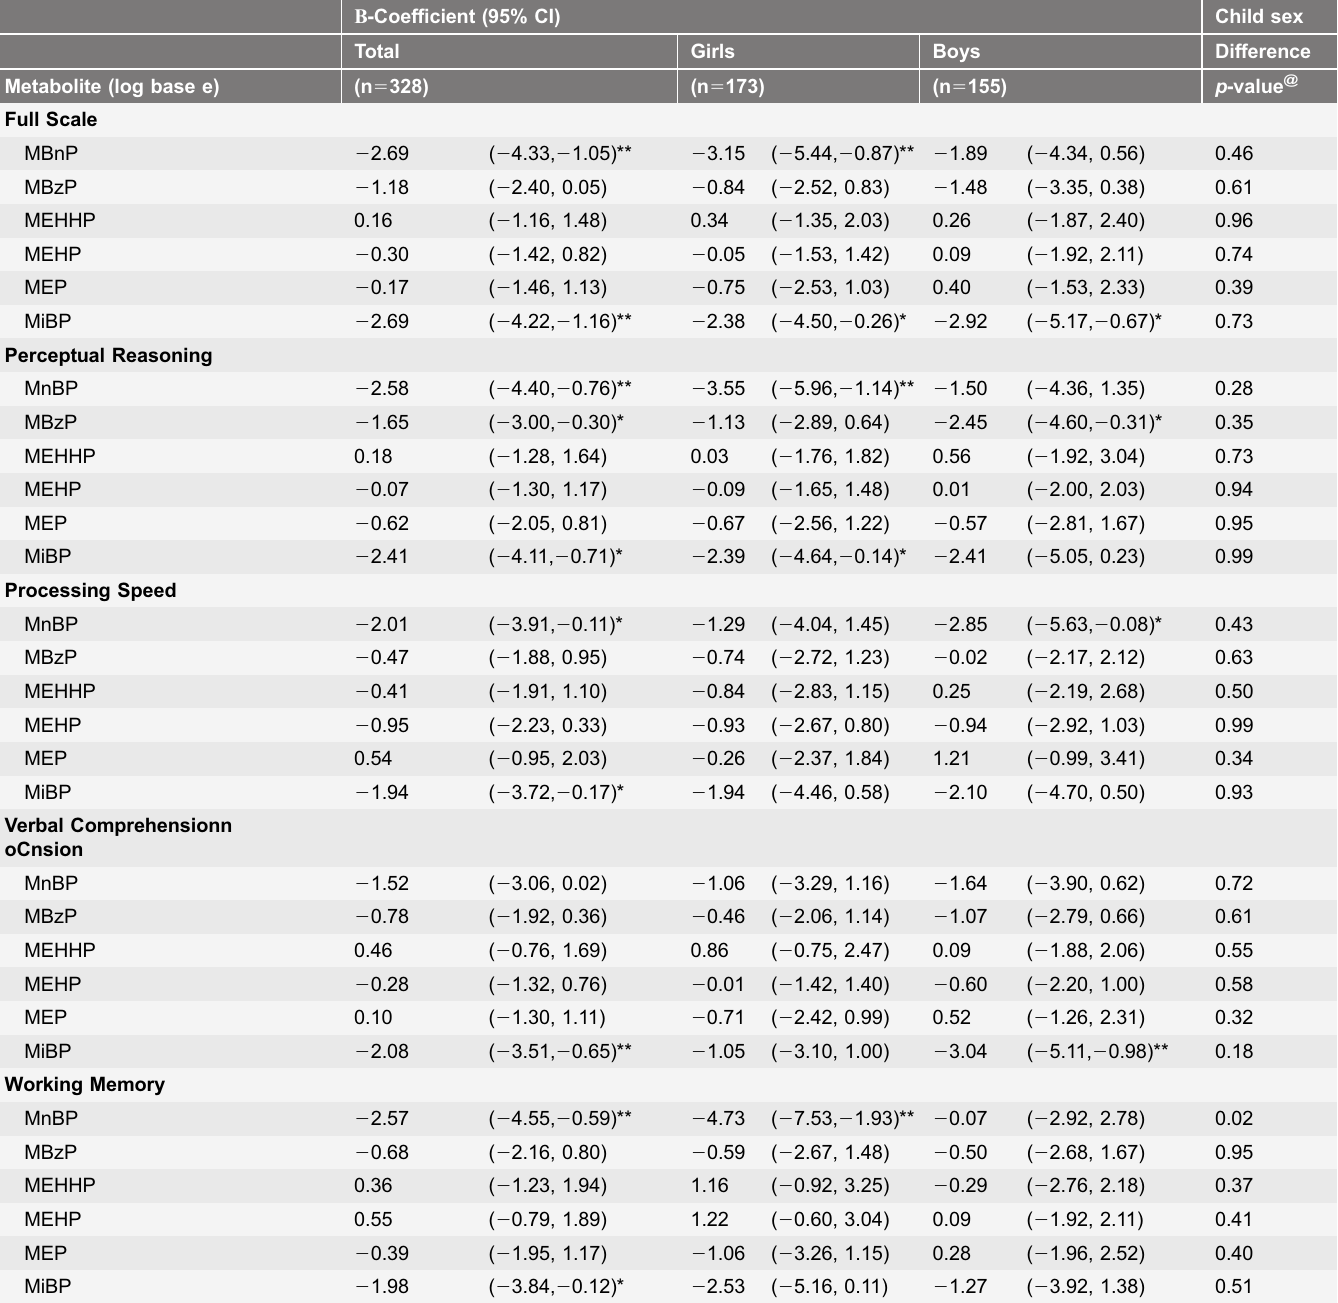
Table 3. Estimated adjusted regression coefficients relating maternal prenatal urinary phthalate concentrations to the WISC-IV full scale IQ and subscales at child age 7